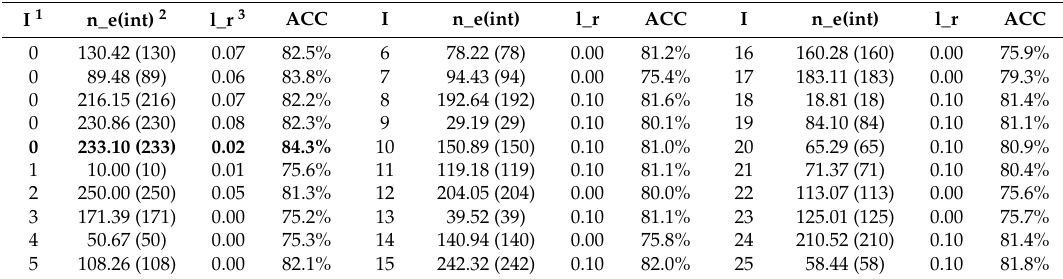
Table 9. Parameter Tuning Process of AdaBoost Classifier.